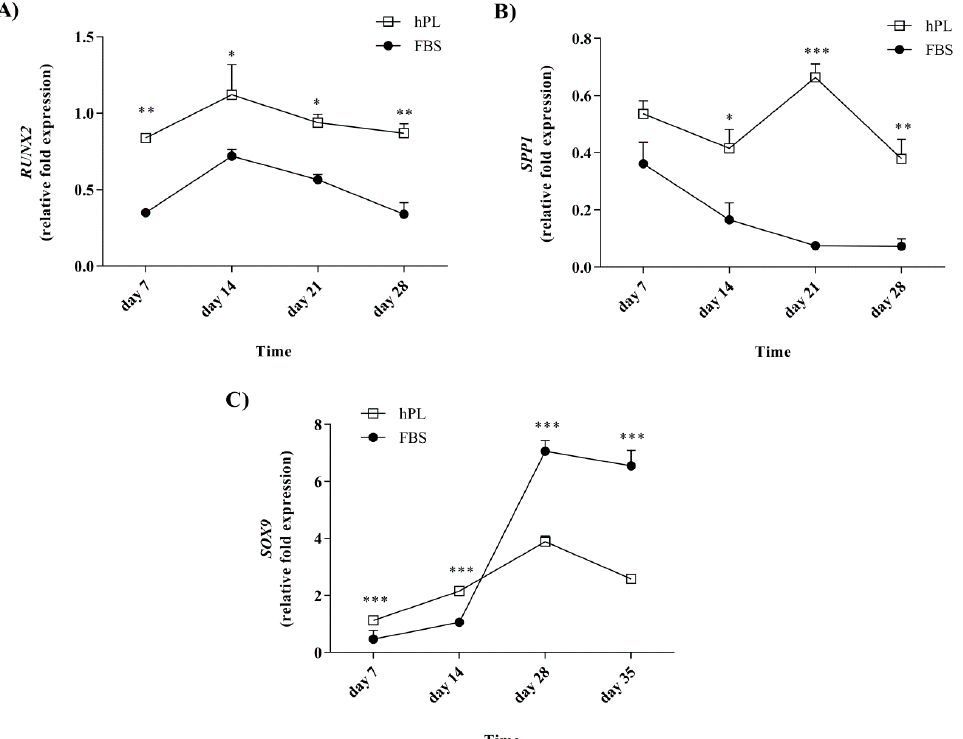
Figure 5. Lineage-specific gene expression during osteogenic and chondrogenic